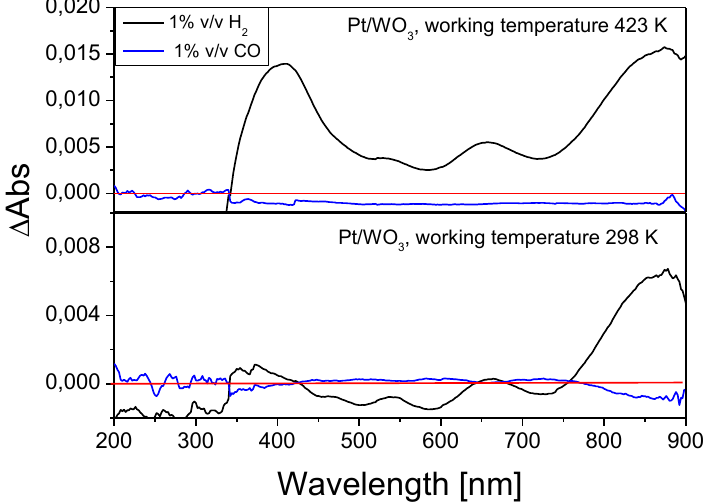
Figure 8. Optical Absorbance Change, ΔAbs = Abs for H and CO at 423 K and room temperature. The red line indicates the zero change in 2 the